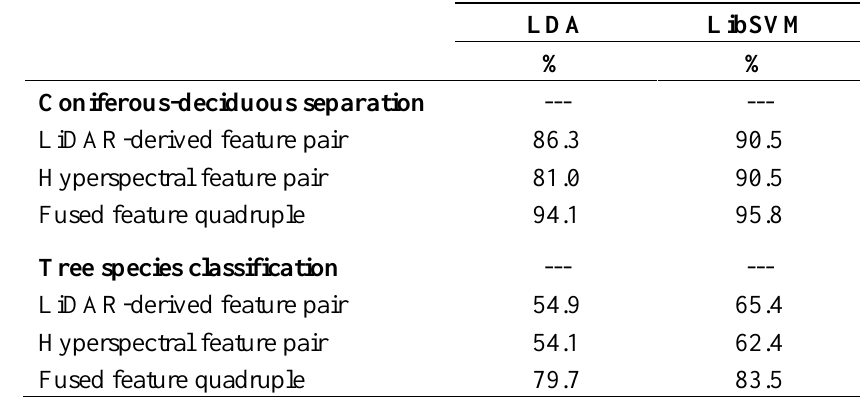
Table 6. Classification accuracy comparison between the results of a Linear Discriminant Analyser (LDA) and the LibSVM. The best result of each case is